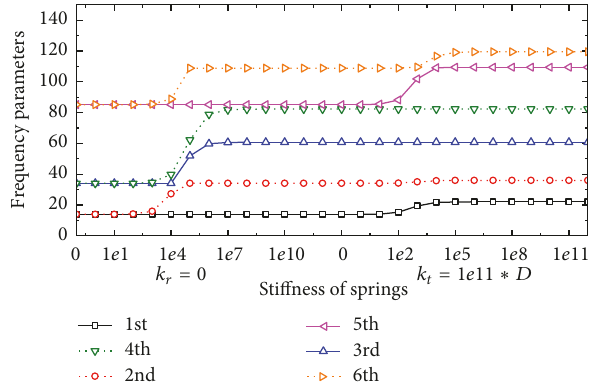
Figure 5: The changing rules of the frequency parameters as the stiffness of the coupling springs